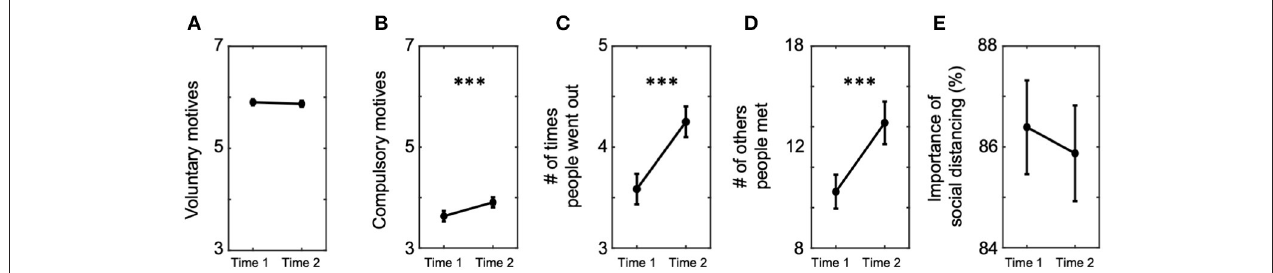
FIGURE 2 | Changes of behavioral intention and motives to follow prevention measures between the two time points. We compared the self-reported behavioral intention and motives of participants. (A) Average voluntary motives to follow prevention measures did not change (Time 1 = 5.90 ± 1.02, Time 2 = 5.87 ± 1.01), whereas (B) average compulsory motives increased at Time 2 compared with Time 1 (Time 1 = 3.63 ± 1.78, Time 2 = 3.91 ± 1.75). (C) Average number of times people went out increased at Time 2 than Time 1 (Time 1 = 3.58 ± 2.59, Time 2 = 4.25 ± 2.61), and so did (D) average number of others they met during the